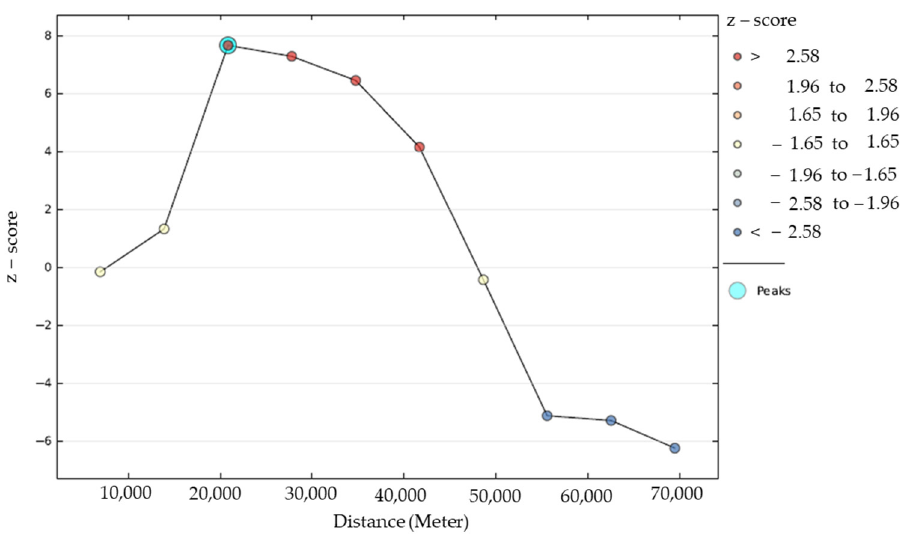
Figure 5. The result of Incremental Spatial Autocorrelations. Table 2. The Results of Township-Based Clusters Analysis of the Feedstock of the Rice